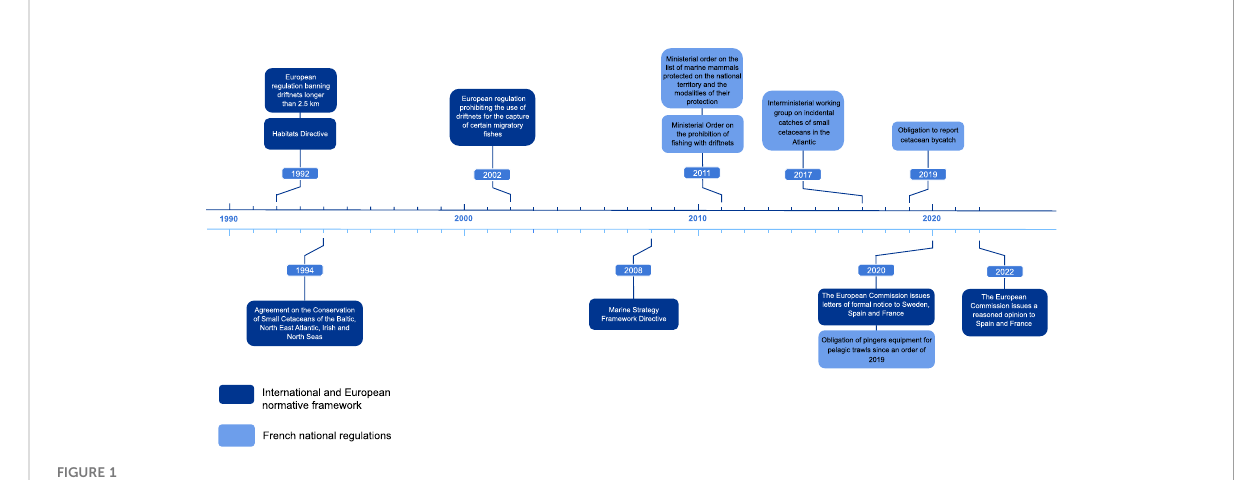
FIGURE 1 Evolution of European and national policies regarding the incidental capture of seabirds and